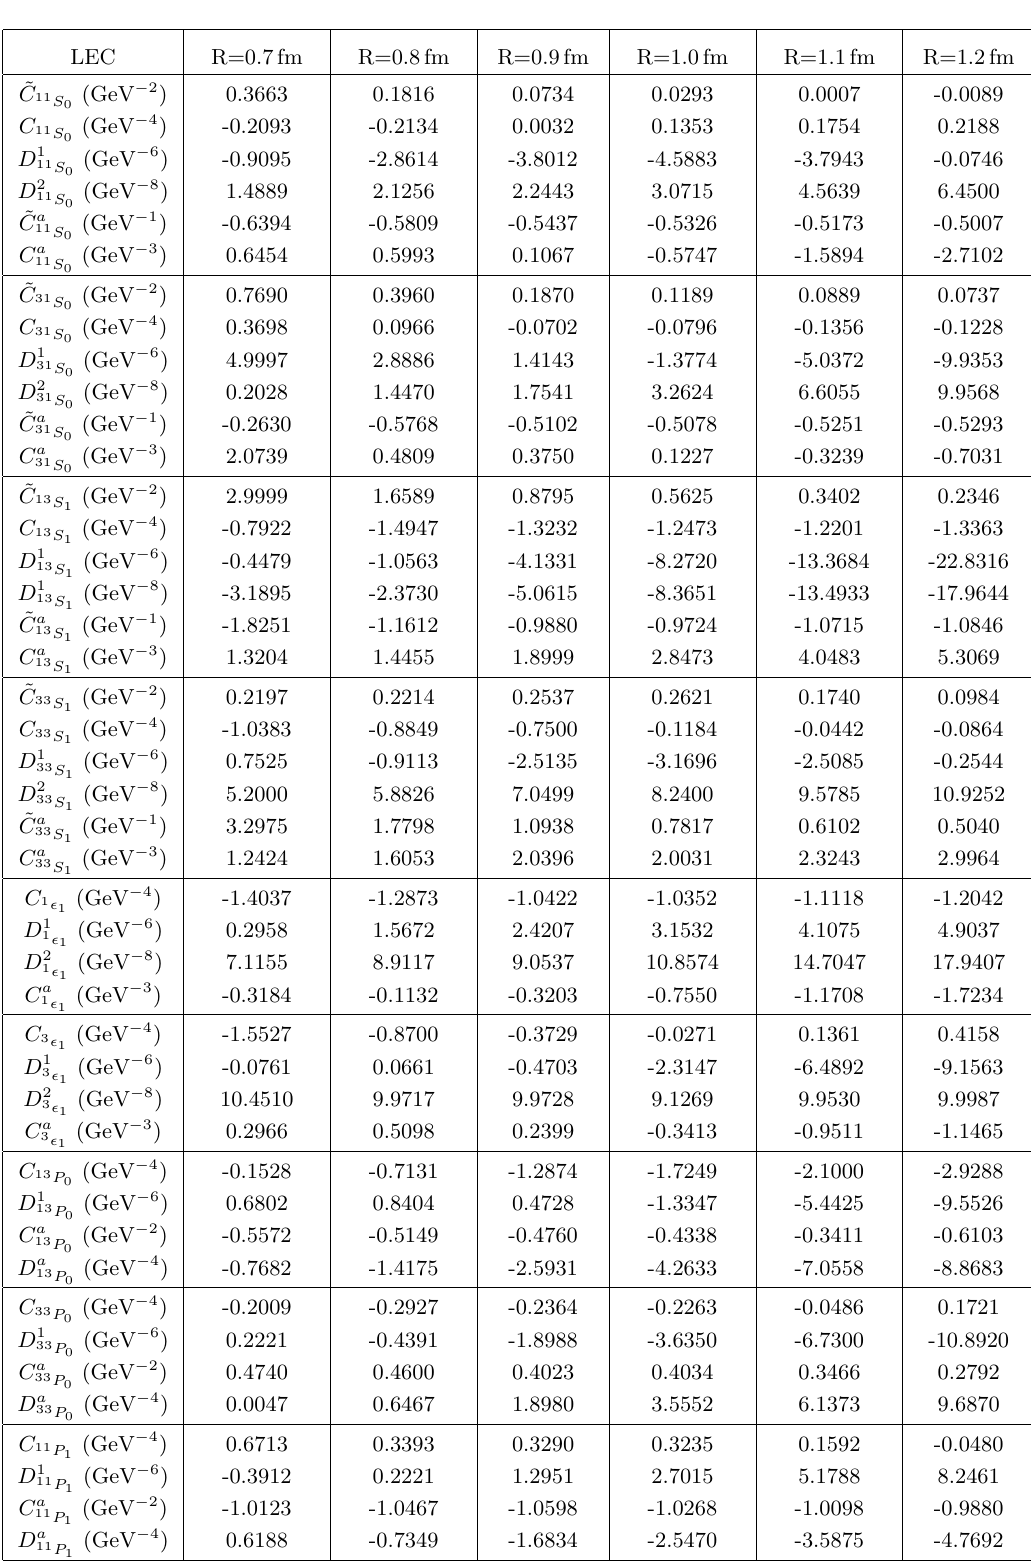
Table 5 . LECs at N 3 LO for di(cid:11)erent cuto(cid:11)s. The superscript a indicates parameters that are related to the annihilation part, cf. eqs. (2.17){(2.22). Note that all parameters are in units of 10 4